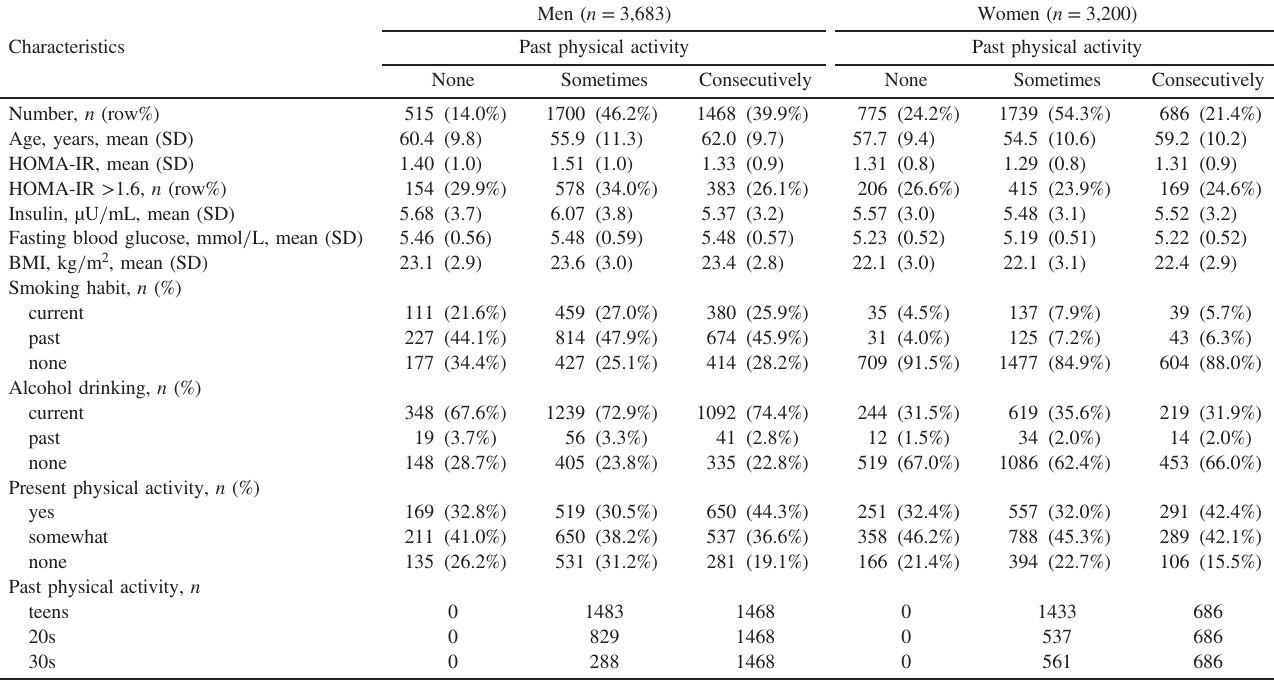
Table 2. Characteristics of study participants according to past physical activity